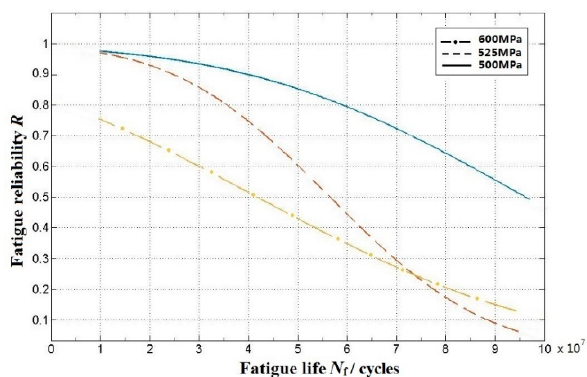
Figure 7. The fatigue reliability curves.